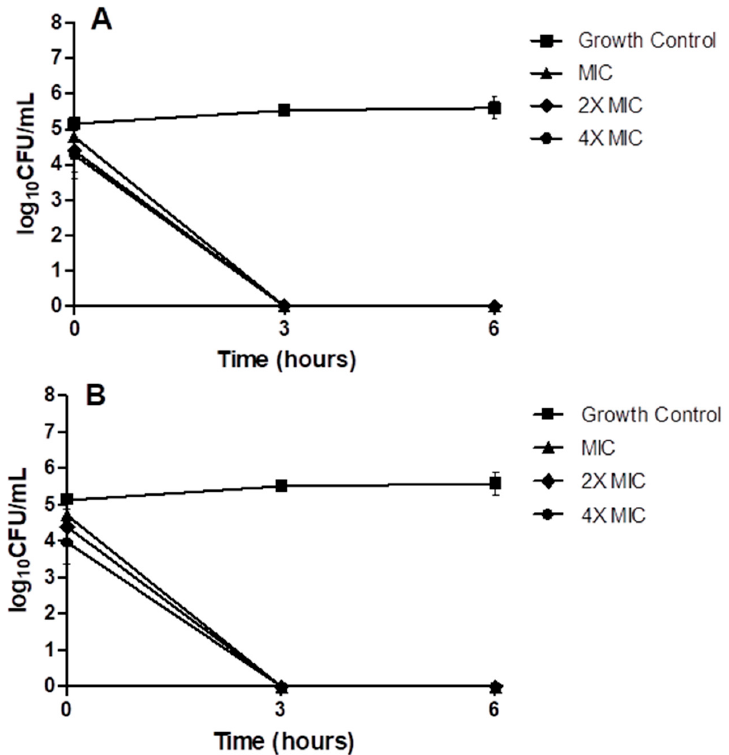
Figure 5. Time-kill curves of S. epidermidis ATCC 35984 incubated in the presence of (p-BthTX-I) 2 and des-Lys 12 /Lys 13 -(p-BthTX-I) 2 . The bacteria were cultured in cation-adjusted BBL Mueller–Hinton II broth (CAMHB) containing 1×, 2×, or 4× MIC concentrations of either ( A ) (p-BthTX-I) 2 or ( B ) des-Lys 12 /Lys 13 -(p-BthTX-I) 2 as indicated. All data points represent the mean of two independent experiments. CFU: Colony Forming Units.